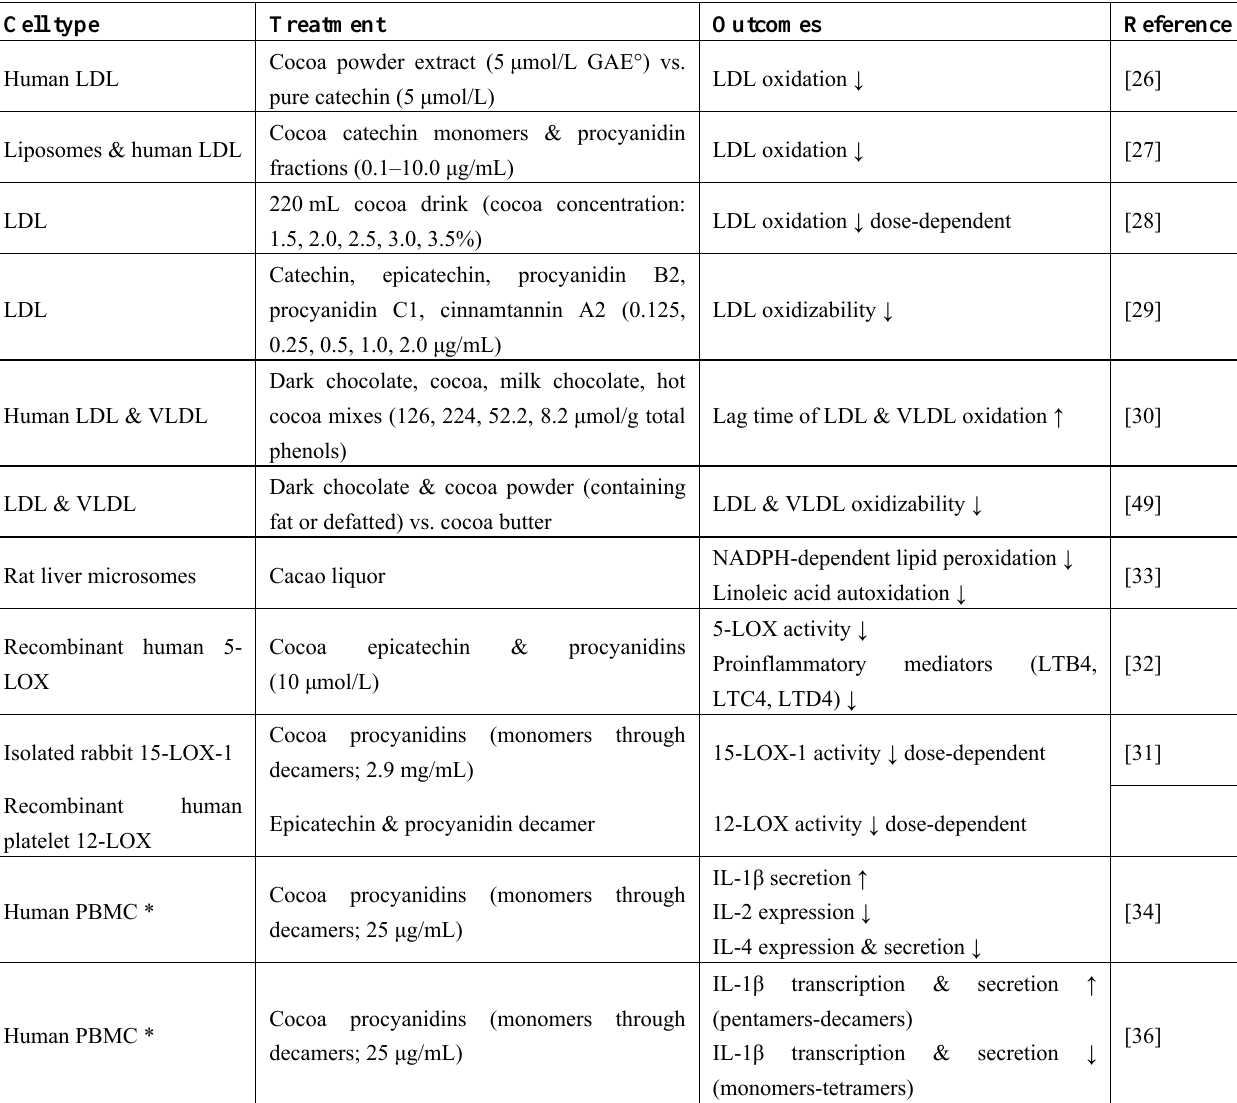
Table 2. In vitro and cell-culture studies performed with cocoa